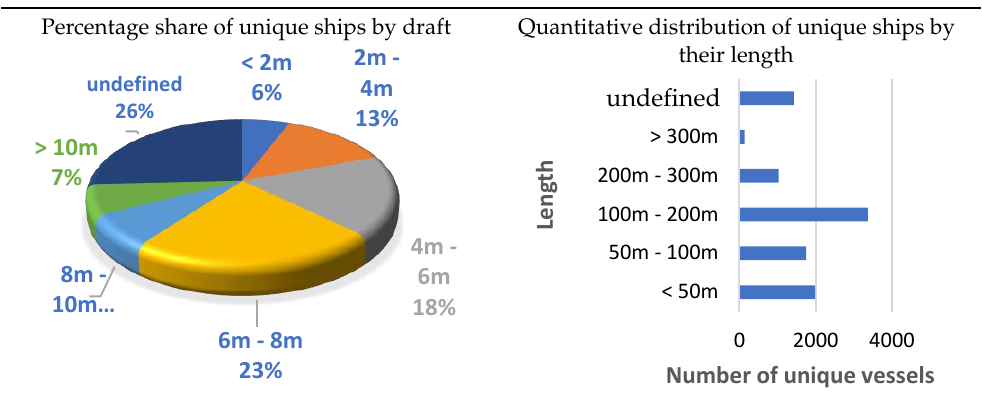
Figure 4. Distribution of traffic intensity for all types of ships covering a large sea area surrounding OWF AIS-PL 2017. Table 2. Qualitative characteristics of all types of ships.